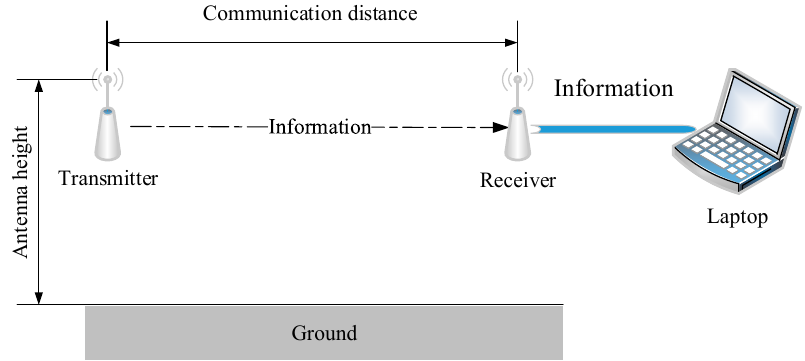
Figure 2. The experiment conducted using two nodes.